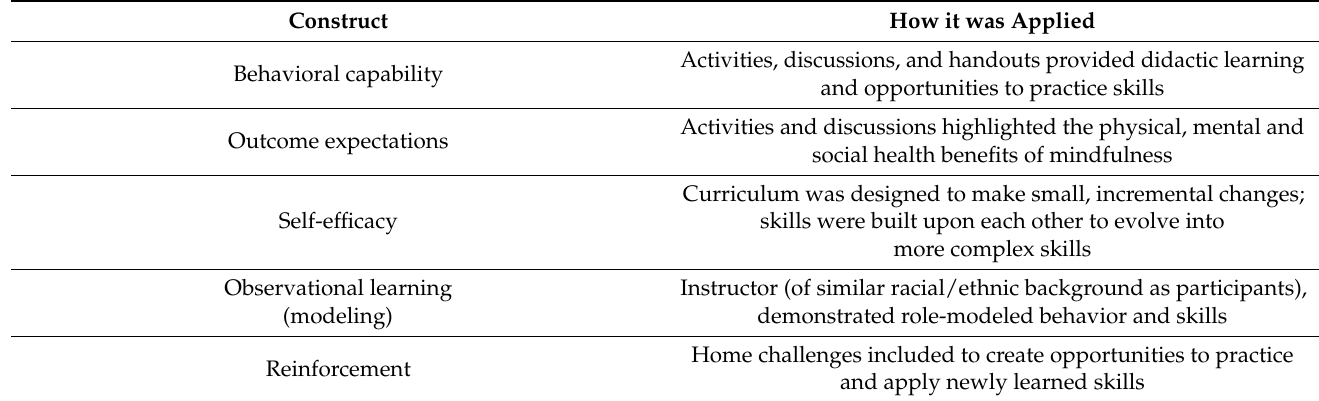
Table 1. Summary of the Applications of Social Cognitive Theory in the Intervention.